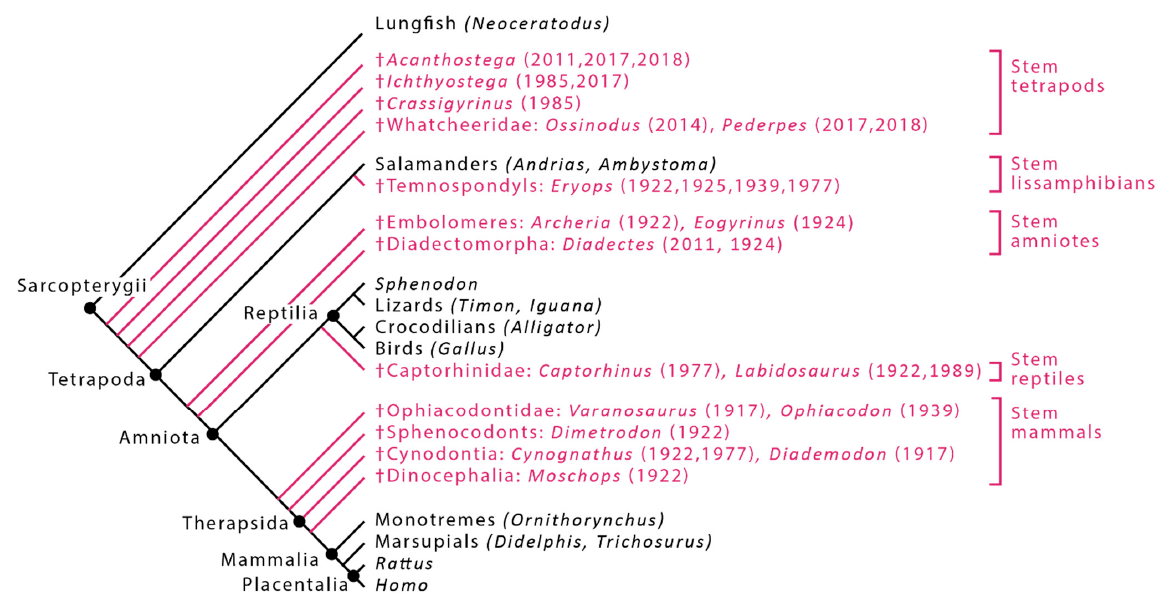
Figure 1. Cladogram showing hypothesized phylogenetic relationships of taxa and the dates of published reconstructions [1,3,4,6,9–11,19–22]. Extant animals are shown in black and extinct animals (†) are shown in red. An extant phylogenetic bracket (EPB) consists of minimally the two closest extant sister groups; for example, the EPB of the stem mammal Dimetrodon would include a crown reptile (e.g., Iguana ) and a crown mammal (e.g., Didelphis ).